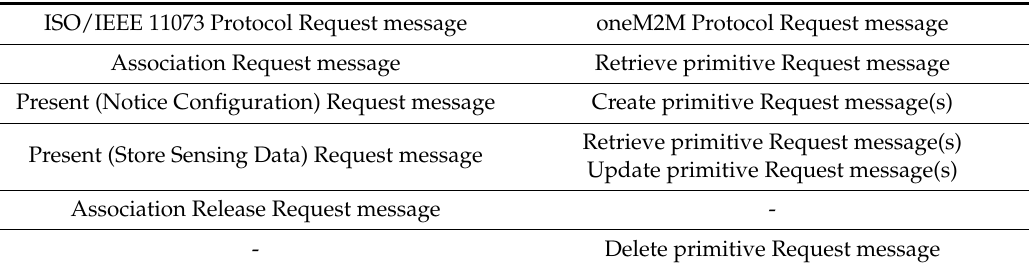
Table 4. Mapping between oneM2M request messages and ISO/IEEE 11073 request